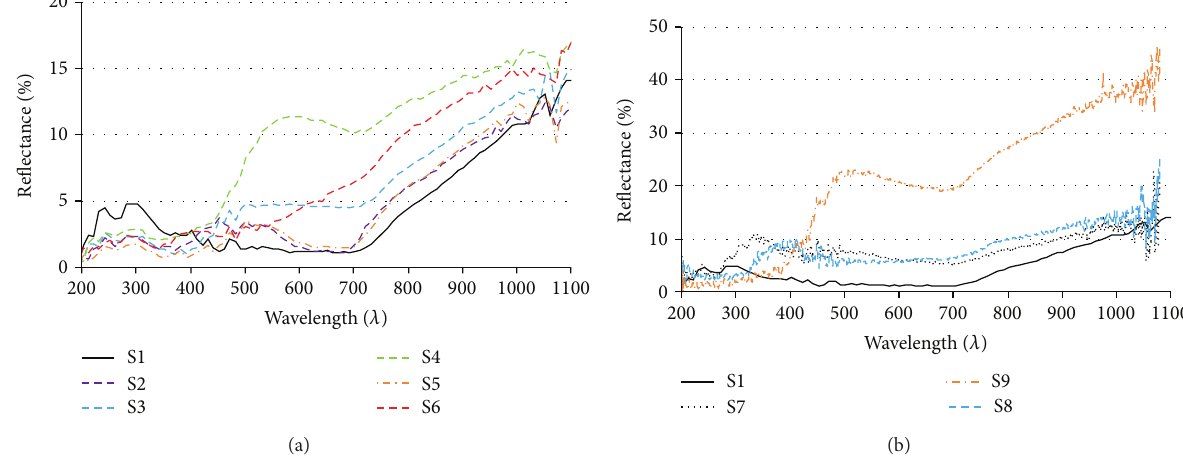
Figure 5: Spectral reflectance of (a) control and blend samples with NIR-reflective pigments and (b) control with NIR reflective and other UV